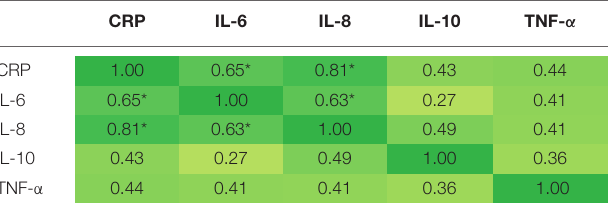
TABLE 4B | The baseline relationship between various inflammatory